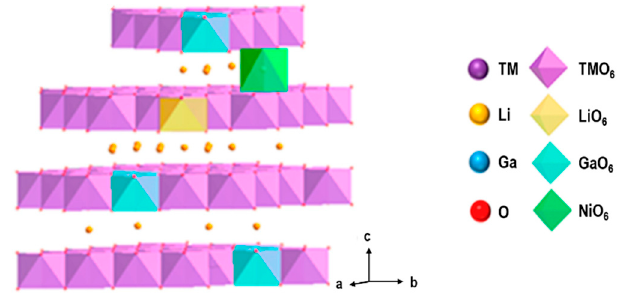
Figure 5. Crystal structure of Ni-rich LiNi 1 − 2y Mn y Co y O 2 (NMC) (y ≤ 0.1). Reprinted from ref. [165] with permission of Elsevier.